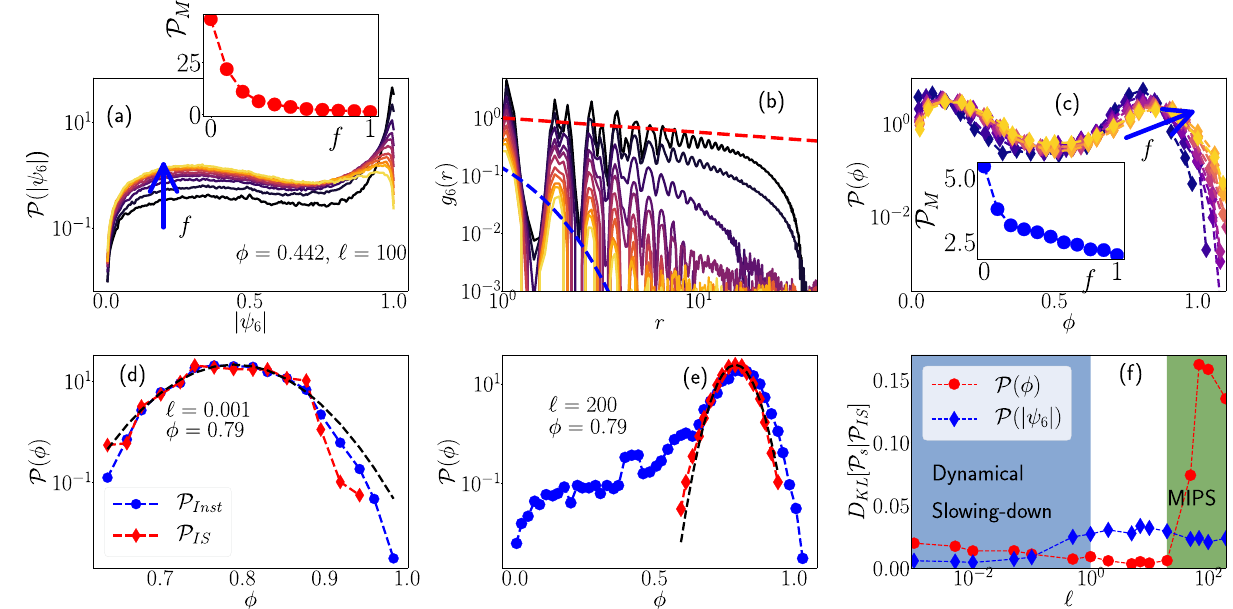
jÞ Fig. 4 The impact of geometrical heterogeneities on motility-induced phase separation. a Probability distribution of the hexatic order parameter P ðj ψ 6 by varying the fraction of heterogeneous particles from f = 0, to f = 1, from black to orange (the arrow points increasing values of f = 0.0, 0.1, 0.2, ..., 1.0). The inset shows the height of the second peak P M (cid:3) (at high ∣ ψ 6 ∣ values) as a function of f . b Spatial correlation function g 6 ( r ) as f increases, from black to orange. The dashed red curve is a power law r − 1/4 , the dashed blue curve is an exponential decay e − r / ξ with ξ ≃ O (1). c Probability distribution of the local packing fraction P ð ϕ Þ by varying f (the arrow points increasing values of f ). The inset shows the height of the peak at high ϕ values as f increases. d P ð ϕ Þ for small persistence length ( ℓ = 0.001) and high density ( ϕ = 0.79), blue circles refer to instantaneous con fi gurations, red diamonds to inherent con fi gurations. The dashed black line is the fi t to a Gaussian function. e P ð ϕ Þ of instantaneous and inherent con fi gurations for large persistence length ( ℓ = 200 and ϕ = 0.79). P IS ð ϕ Þ is well captured by a Gaussian fi t (dashed black line). f Kullback-Leibler divergence D KL between stead-state ( P S ) and jÞ (blue inherent ( P IS ) distributions for the two observables, i.e., P ð ϕ Þ (red circles) and P ðj ψ 6